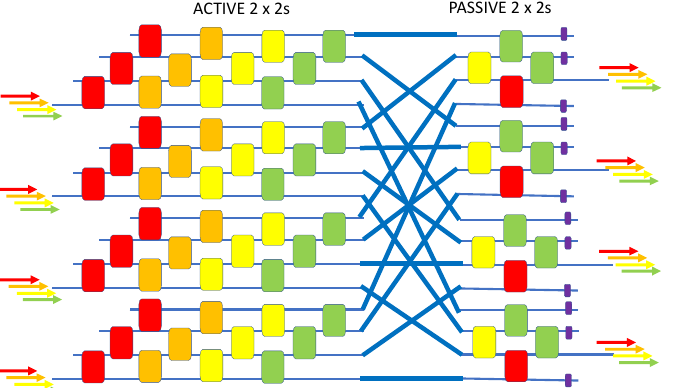
Figure 14. Block diagram of the 4 × 4 × 4λ wavelength cross-connect switch.